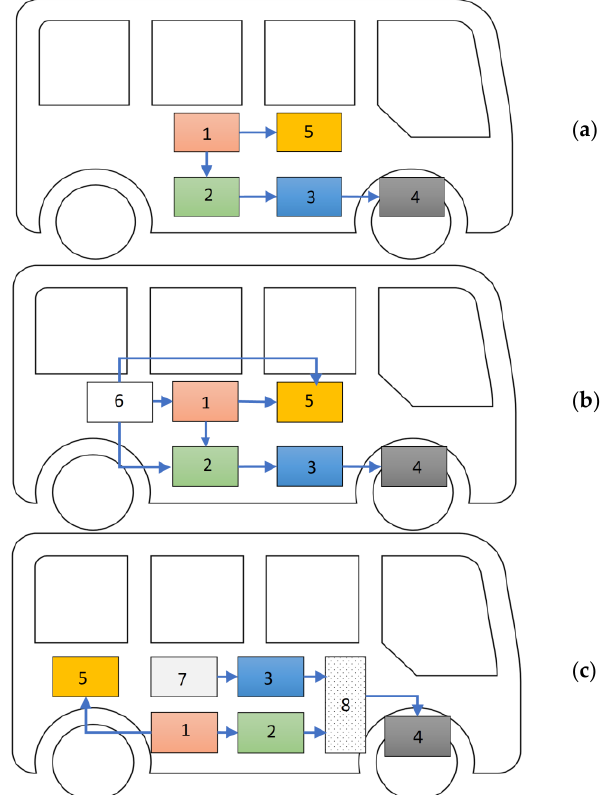
Figure 1. General structures of electric and hybrid powertrains used in the construction of buses: ( a ) electric bus; ( b ) hybrid series; and ( c ) hybrid parallel. 1, battery; 2, electric motor; 3, transmission; 4, final drive; 5, auxiliaries; 6, generator; 7, engine; and 8, torque converter/coupler.